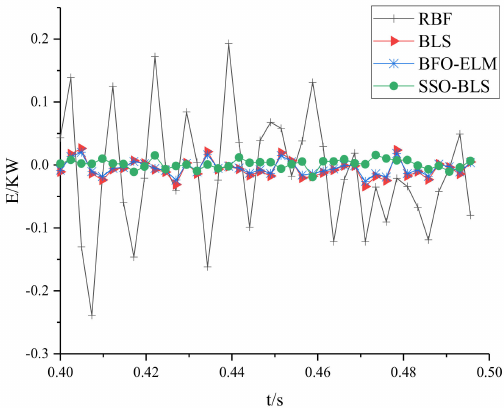
Figure 6. Comparison of modeling errors of different algorithms under single–phase fault condition.